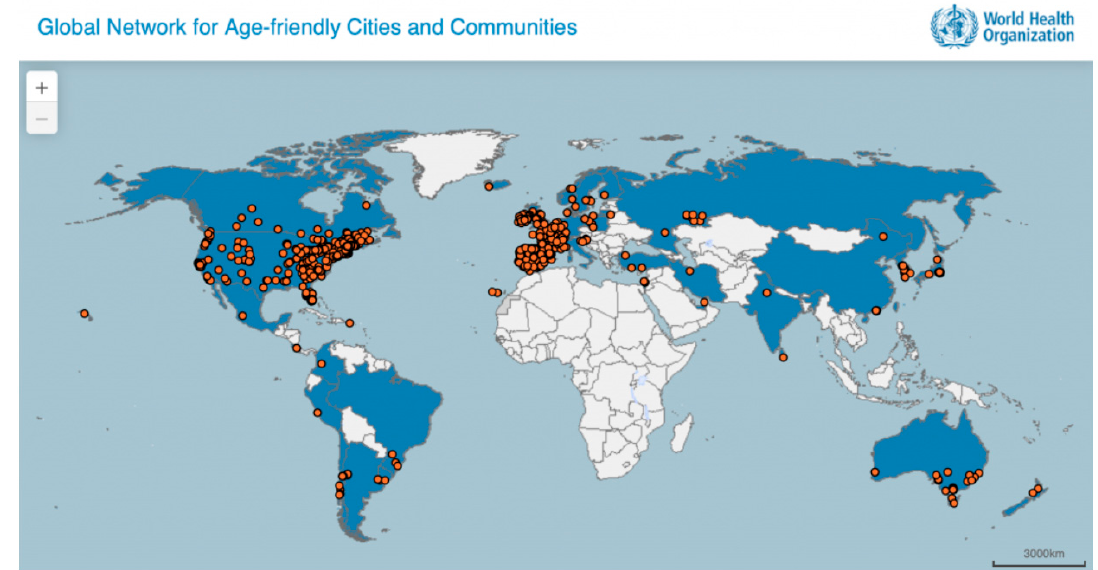
Figure1. NocityinRomaniahasyetjoinedtheGlobalNetworkforAge-friendlyCitiesandCommunities Figure 1. No city in Romania has yet joined the Global Network for Age-friendly Cities and (status quo July 2020) Communities (status quo July 2020) [23].